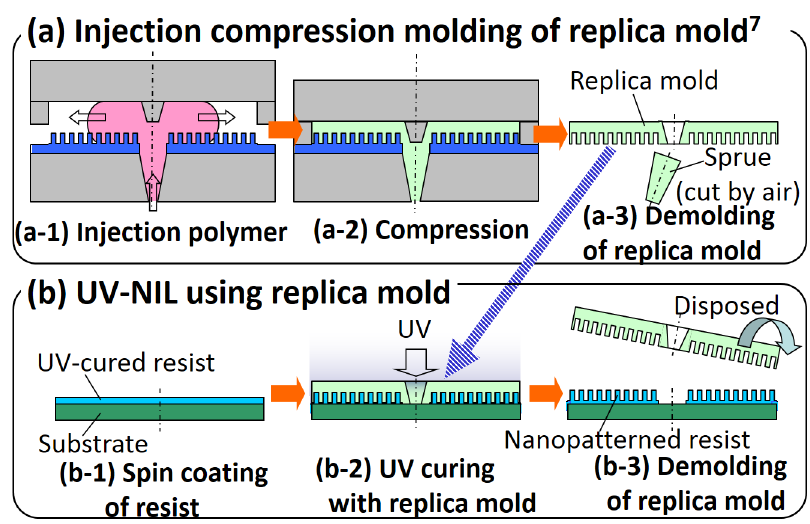
Figure 1. Schematic of ultraviolet nanoimprint lithography (UV-NIL) using an injection-compression-molded replica mold. ( a ) Injection compression molding (ICM): ( a-1 ) injection of melted polymer, ( a-2 ) polymer is compressed and cooled, and ( a-3 ) replica is demolded and sprue is cut off by an air jet. ( b ) UV-NIL: ( b-1 ) UV-cured resist is spin-coated onto a substrate; ( b-2 ) replica mold is pressed, UV light is irradiated, resist is cured; and ( b-3 ) replica mold is demolded and disposed